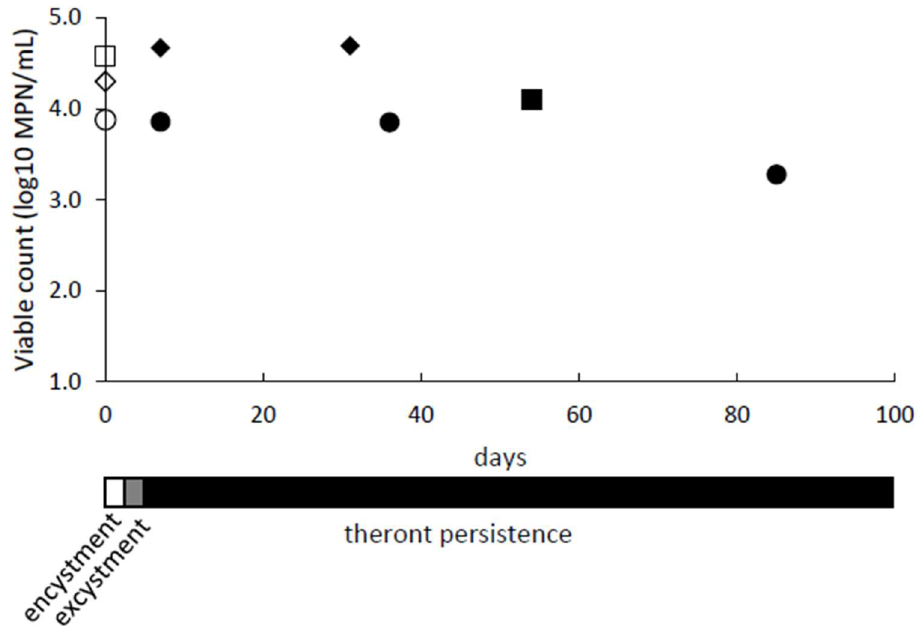
Figure 4. Theronts persist under starvation conditions. Trophonts cultures were encysted in encystment buffer at 26 °C, resulting in cyst suspensions on days 1 and 2. The cysts were transferred to 20 °C, and excystment of theronts was completed by day 7. They were then maintained under starvation conditions for a further 24, 47, or 78 days. The viable counts (log10 MPN/mL) are shown for the trophonts on day 0 (empty symbols) and theronts (filled symbols) for three experiments (circles, diamonds and squares). A summary timeline for encystment, excystment and theront persistence is given.